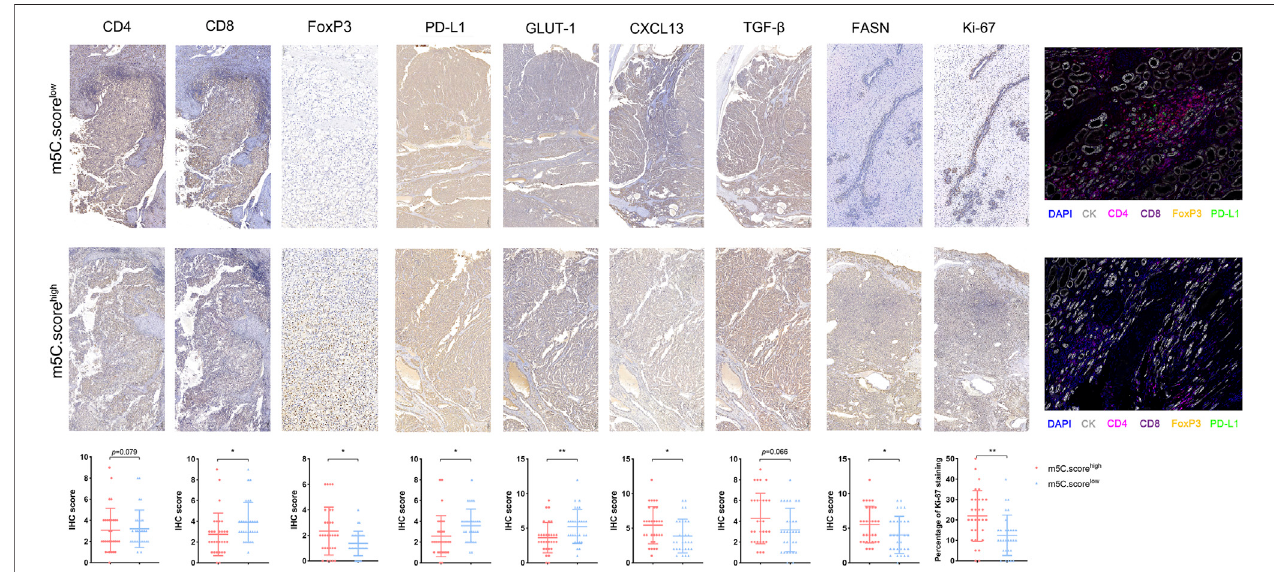
FIGURE10| TMEcharacterizationinthem 5 Cmodi fi cationphenotypes.TMEcharacterizationassessmentbetweenhighandlowm 5 CscoregroupsbasedonIHC staining (CD4, CD8, FoxP3, PD-L1, GLUT-1, CXCL13, TGF- β , FASN, Ki-67) and opal multimarkers IHC staining (DAPI, CK, CD4, CD8, FoxP3, PD-L1).